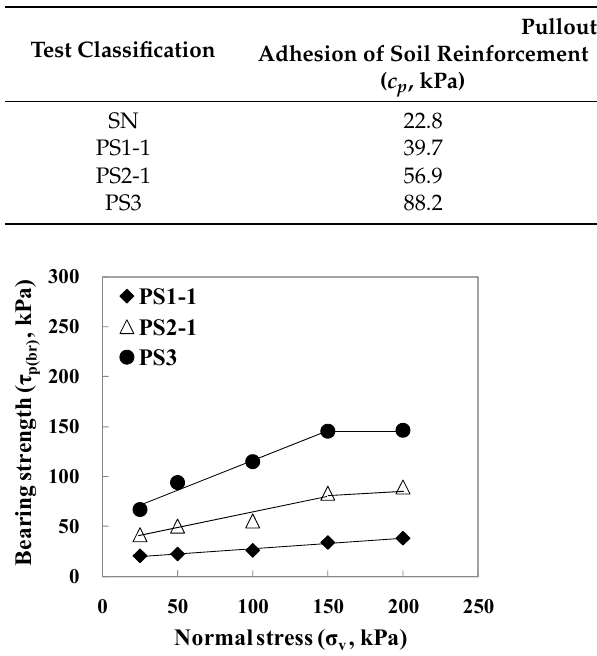
Figure 6. Relationship between normal stress and bearing strength.